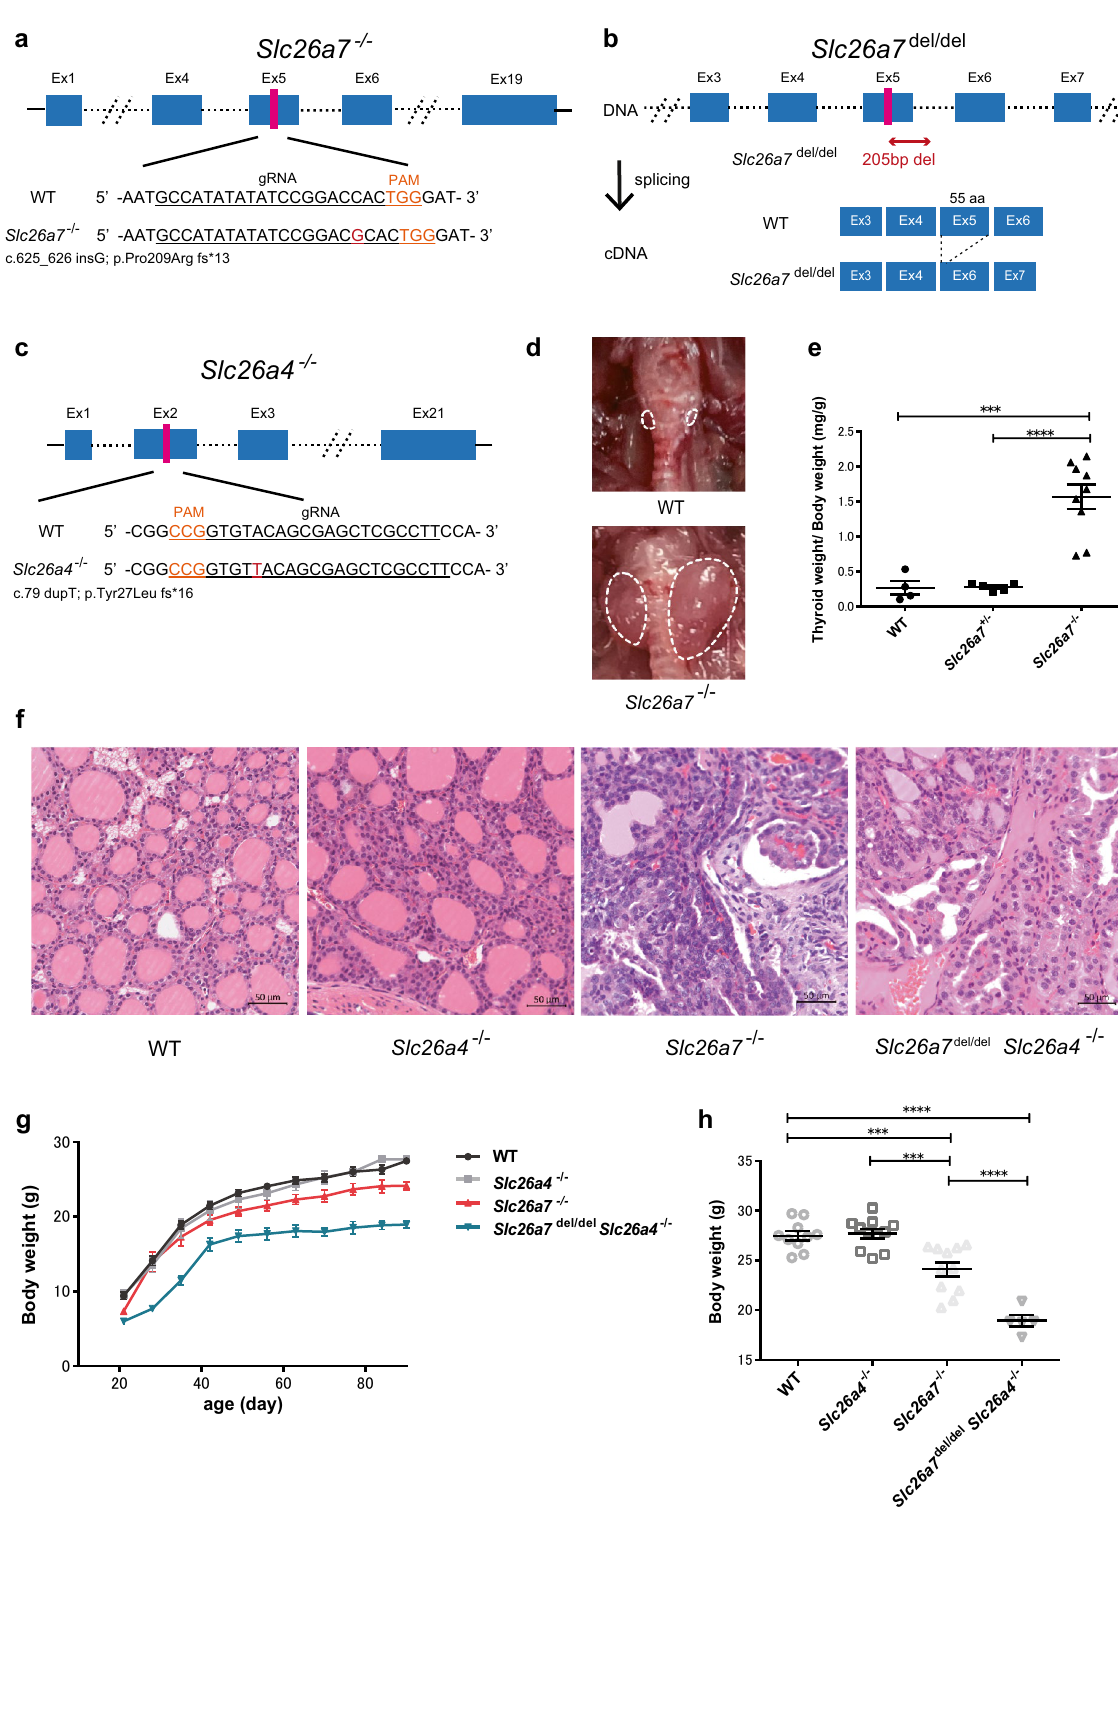
(cid:18604)(cid:18604)(cid:18604)(cid:18604)(cid:18604)(cid:18604)(cid:18604)